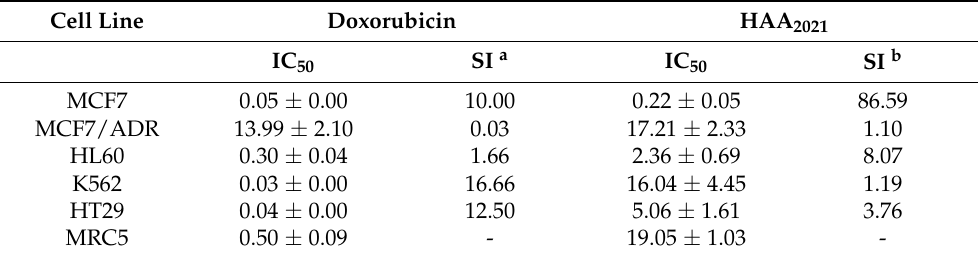
Table 1. Cytotoxic activity (MTT 72 h, IC 50 ± sd µ M) of doxorubicin and HAA 2021 against five cell lines and one normal fibroblast.